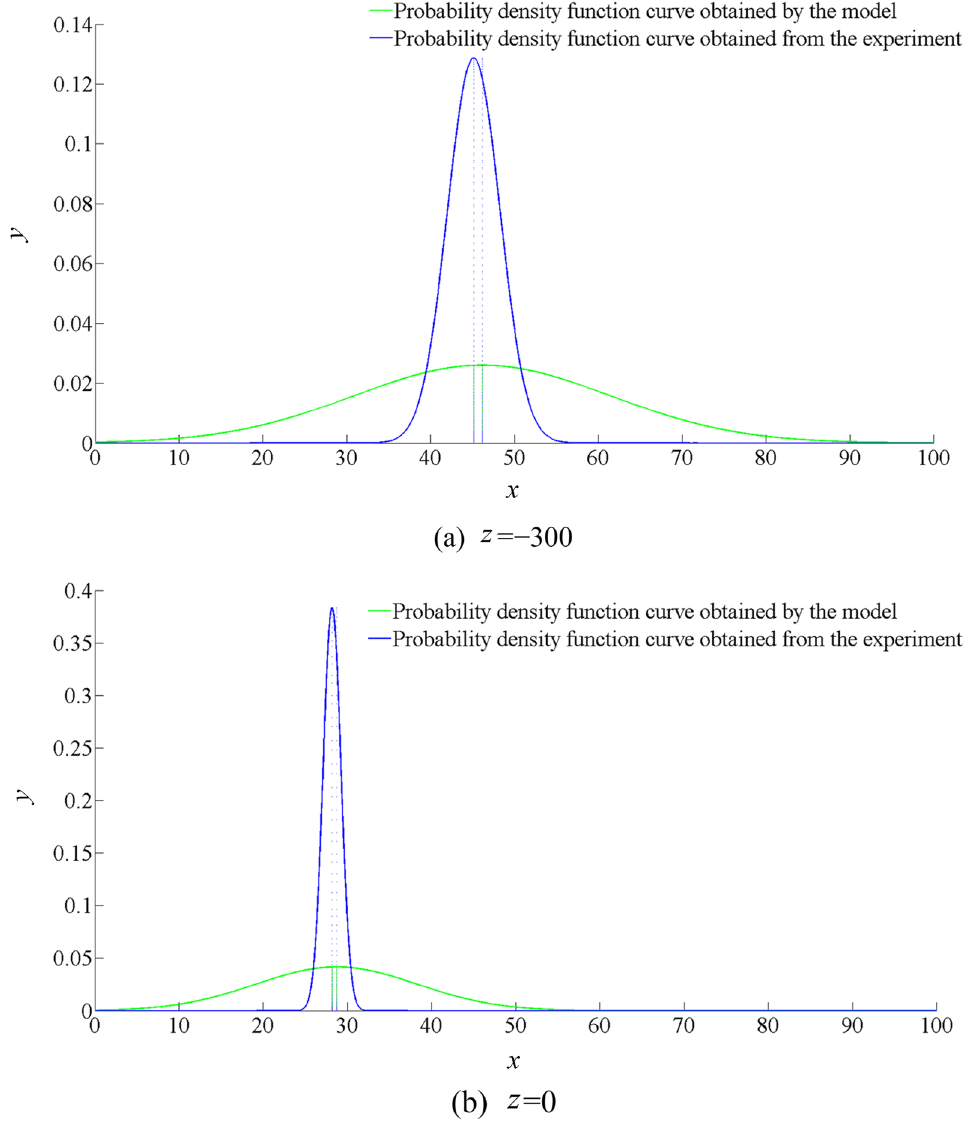
Figure 9 The geometric error distribution of the machine tool in four different Z